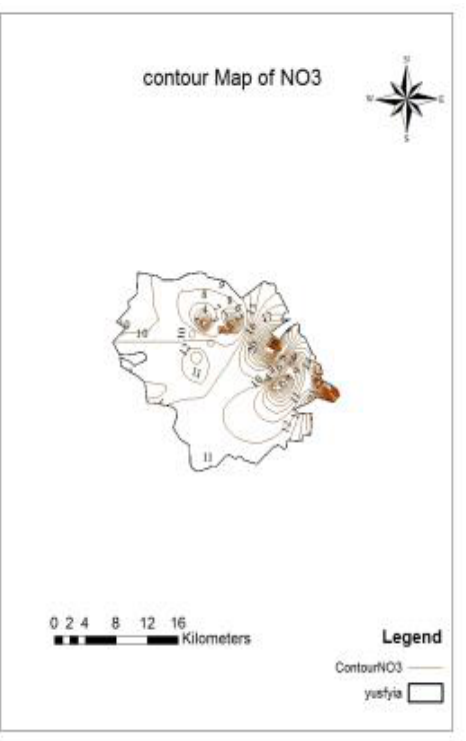
Fig.12: The interpolation and contour line of NO map in ppm. 3